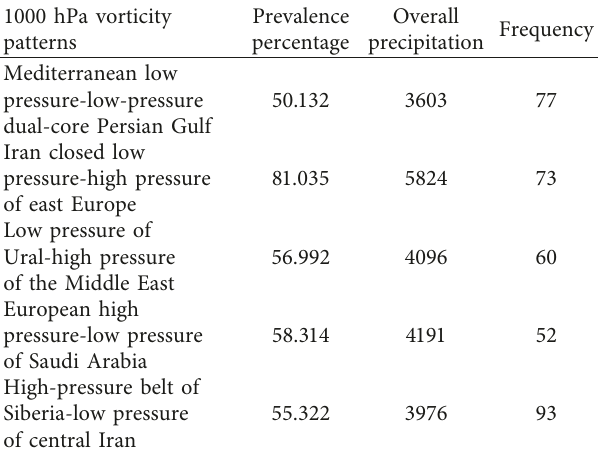
Table 1: Some of the characteristics of identified patterns of prevalent winter precipitation in